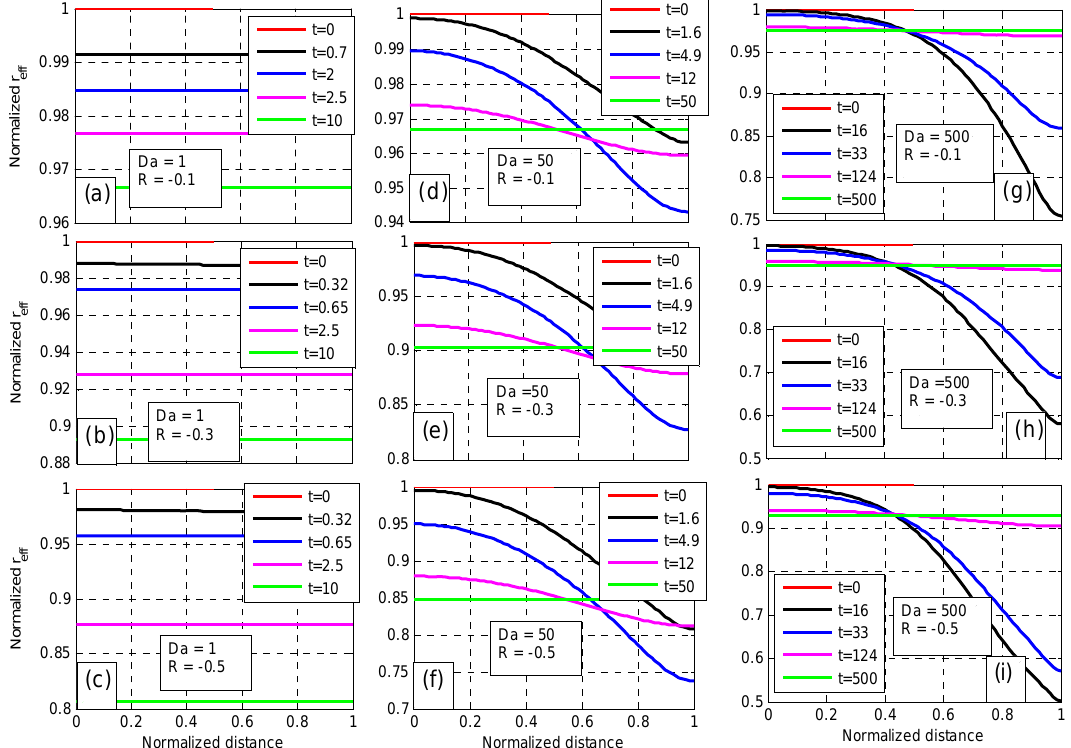
Figure 14. Spatial dependencies of effective radius at different time instances and at different values of Da and different R > −